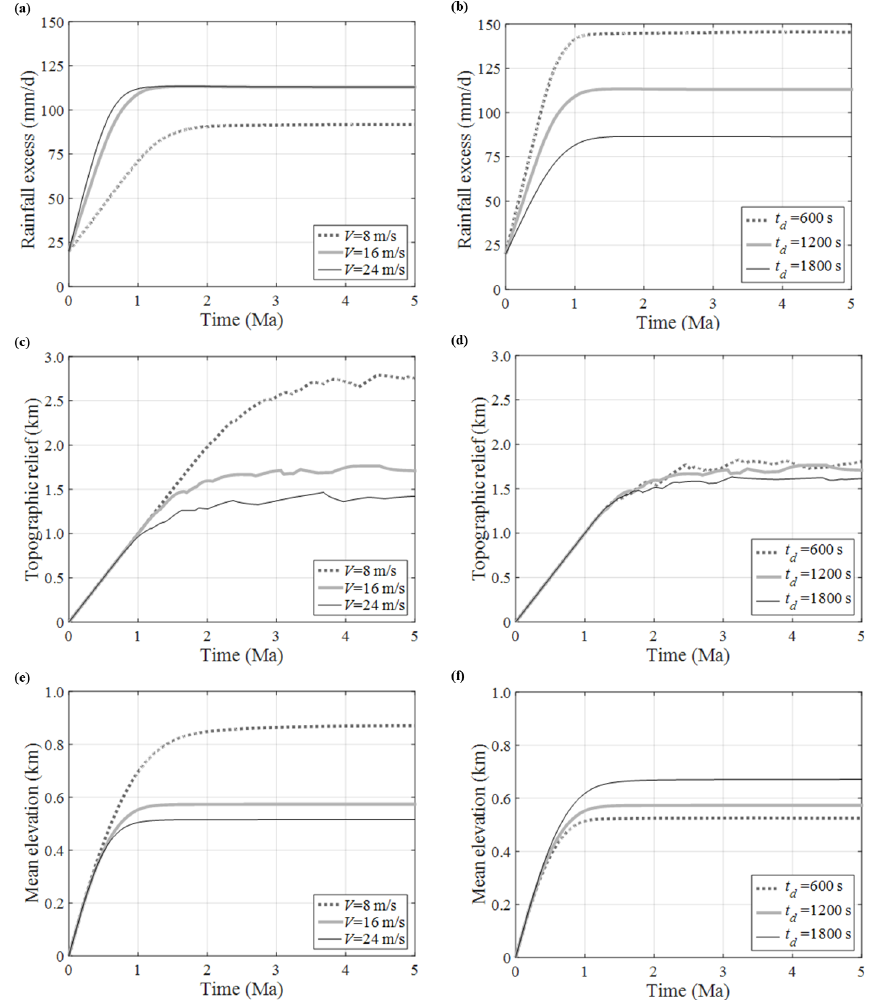
Figure 7. Variations of (a, b) domain-averaged rainfall excess, (c, d) topographic relief, and (e, f) mean elevation during co-evolution simulations with different (a, c, e) V ( t d fixed as 1200s) or (b, d, f) t d ( V fixed as 16ms − 1 ).